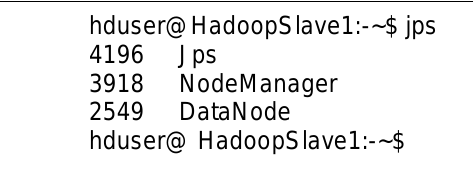
Figure 6a . Hadoop Services on master node Figure 6b . Hadoop Services on slave node